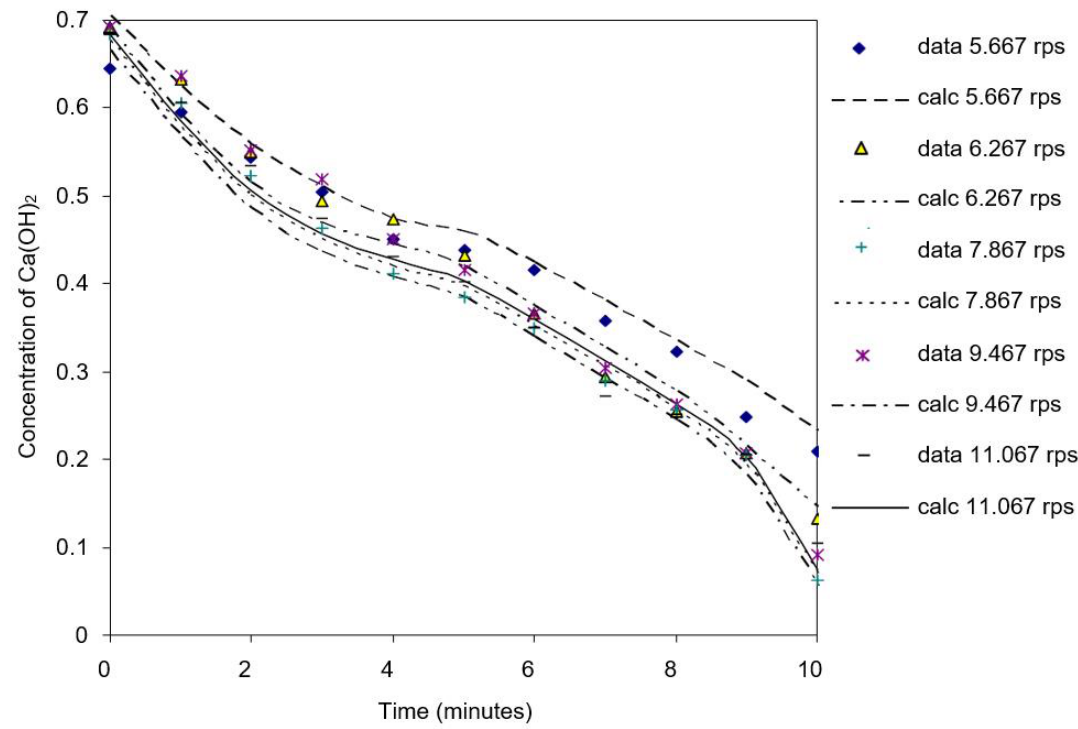
Figure 2. The relationship between the concentration of Ca(OH) 2 with time at a various stirring